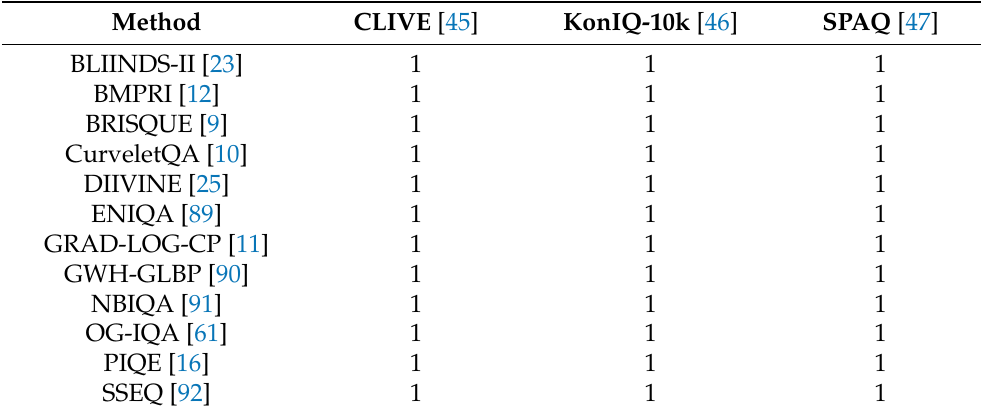
Table 10. Results of the significance tests. Symbol 1 ( − 1 ) denotes that the proposed FLG-IQA algorithm is significantly (95% confidence interval) better (worse) than the NR-IQA algorithm in the row on the IQA benchmark database in the column.